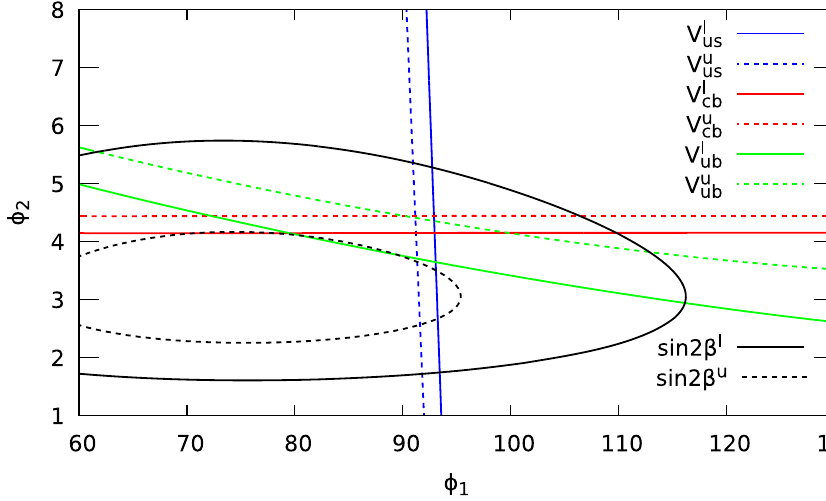
Fig. 1 Contours of | V | , | V | , | V | and sin 2 β in us cb ub φ − φ 1 2 plane, for the mean values of quark masses and central values of allowed ranges of D u and D d . The solid lines are for the lower limit of the ranges mentioned in the Table 1, while the dashed lines are for the upper